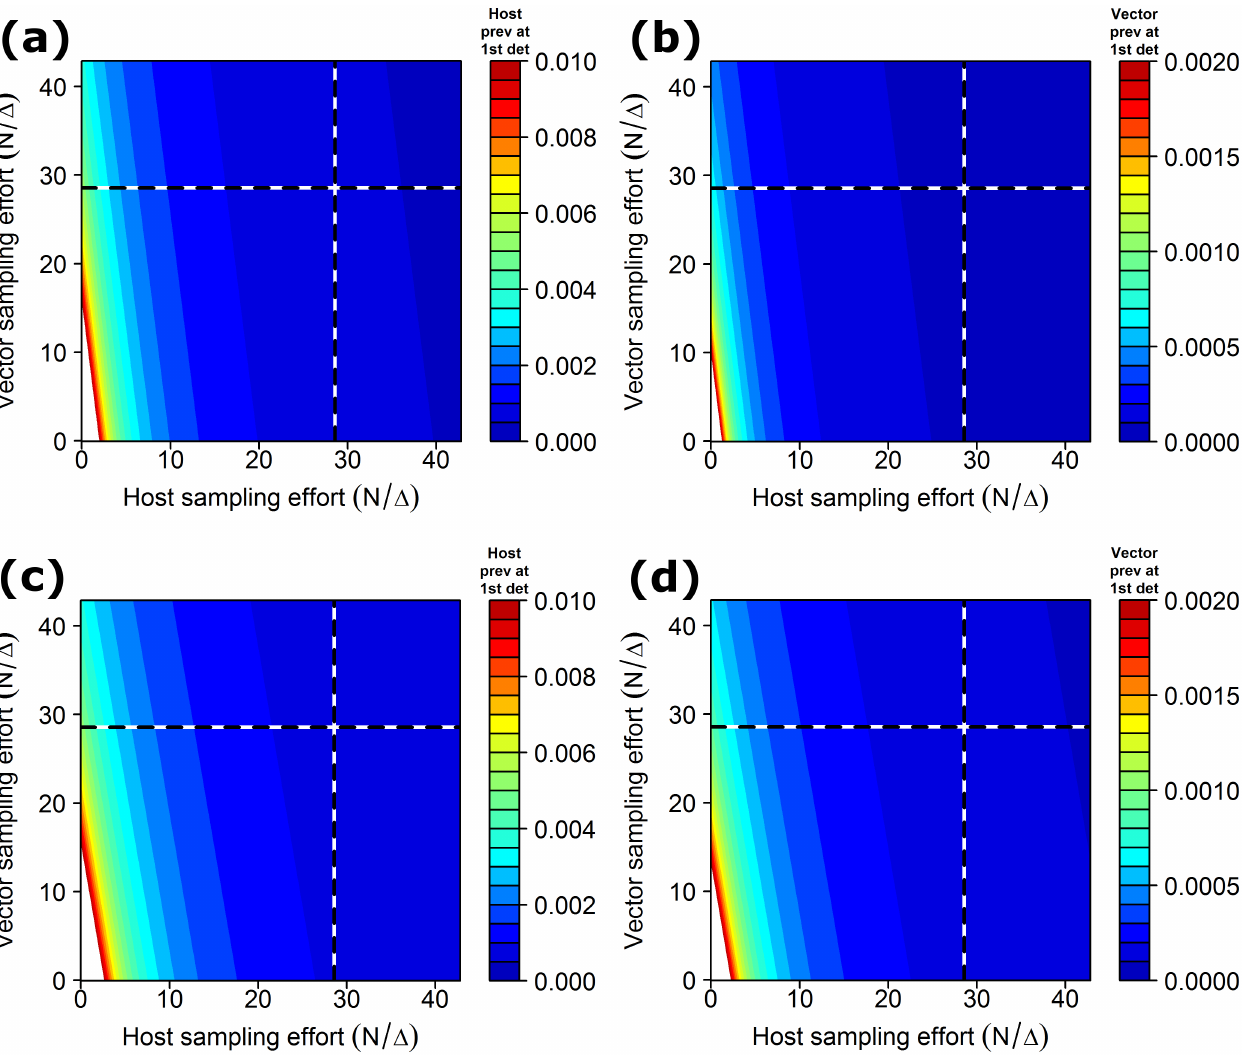
(cid:0) (cid:1) on the mean prevalenceat first detection for the HLB model (panels (a) and (b) and the Fig 1. Effect of varying sampling effort y ¼ N D tristeza model (panels (c) and (d). The estimated prevalence at first detectionin hosts is shown in the graphson the left, and that in vectors is shown in the graphson the right. The dashedline indicatesa host (vertical line) and a vector (horizontal line) samplingeffort of 800 samples per 28 days, with the intersection of these dashed lines indicating a theoretical scenarioin which a total of 800 hosts and 800 vectors were sampled.